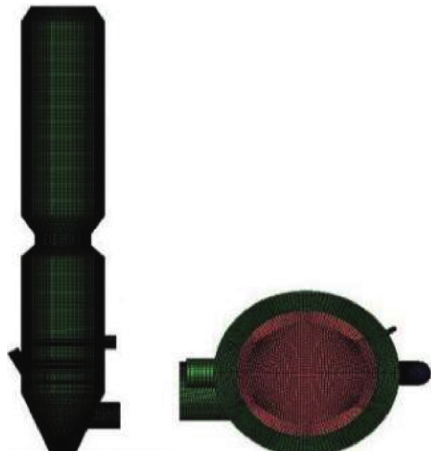
Figure 3: Decomposing furnace meshing